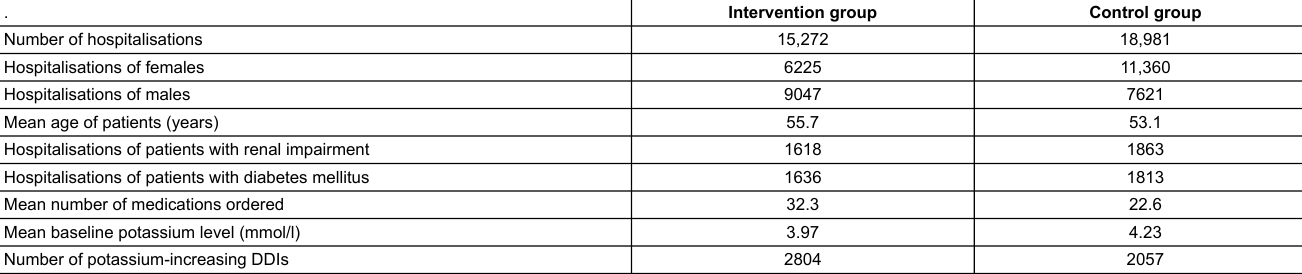
Table 1: Characteristics of hospitalised patients, important comorbidities [23], and factors related to serious potassium-increasing DDIs by study group. .